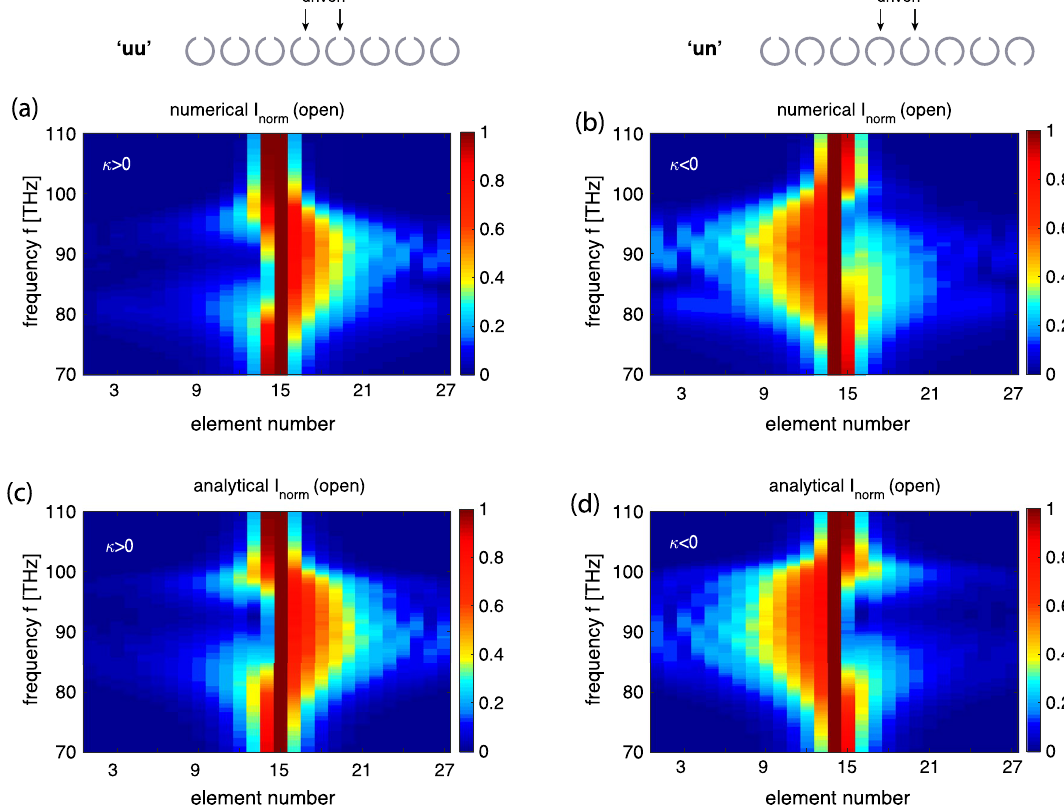
Figure 8. The normalised current distribution in the 27 elements of the EI waveguides over frequency, for the ‘uu’ array (left column) and for the ‘un’ array (right column) shown schematically in the insets, with elements 14 and 15 excited as indicated by arrows. ( a ), ( b ): numerical simulation. ( c ), ( d ): analytical model